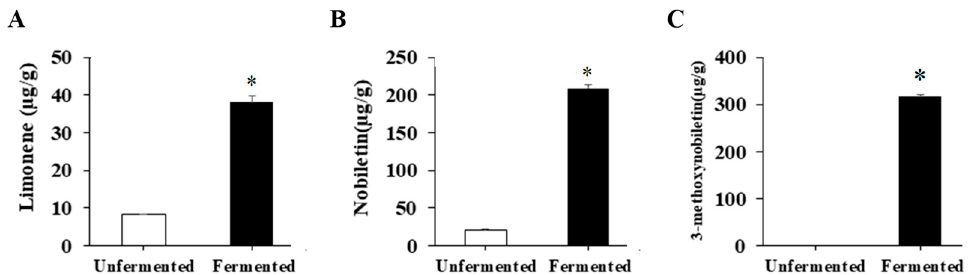
Figure 1. The levels of limonene, nobiletin and 3-methoxynobiletin in unfermented and fermented citrus peel. The citrus peel was fermented, and the levels of ( A ) limonene, ( B ) nobiletin and ( C ) 3-methoxynobiletin in unfermented and fermented citrus peel were determined by HPLC as described in the Materials and Methods section. Result are expressed as mean ± SD ( n = 3). * p < 0.05 compared with unfermented citrus peel.